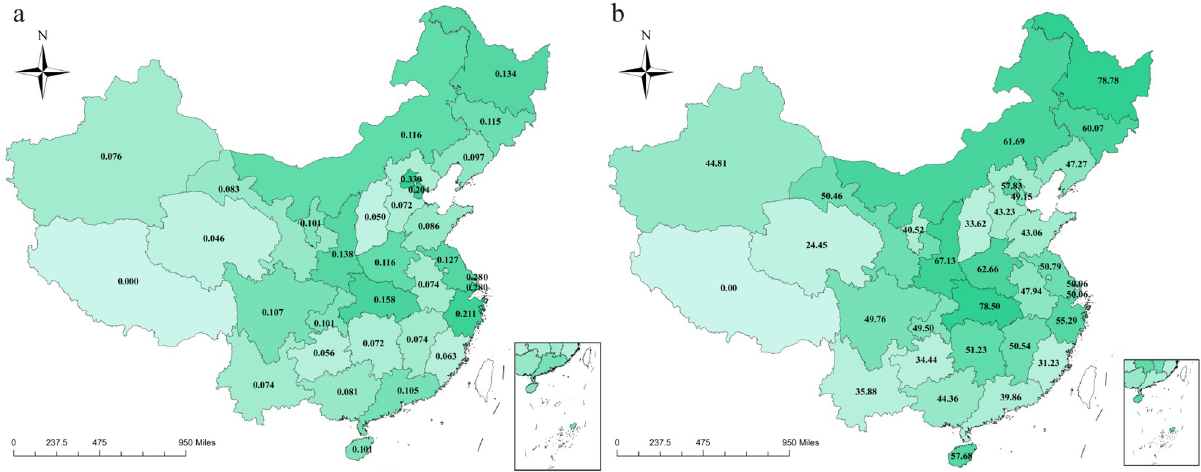
Fig 2. Instant impacts of COVID-19 on OEH visits per capita in mainland China. (a) This panel depicts the absolute instant impact of COVID-19 on monthly OEH visits per capita in February 2020 by province. Different background colors represent different regions of mainland China. The darkness of each block indicates the loss of monthly OEH visits per capita in February 2020 of each province (Tibet was excluded because of missing data). (b) This panel depicts the relative instant impact in February 2020 by province. The darkness of each block indicates the relative reduction on monthly OEH visits per capita in February 2020 of each province, compared to the pre-pandemic level. Tibet was excluded because of missing data. Maps were created using ArcGIS by ESRI version 10.8 (http://www.esri.com) [21]. Base map sources were at http://bzdt.ch.mnr.gov.cn/ and https:// dataverse.harvard.edu/dataset.xhtml?persistentId=doi:10.7910/DVN/DBJ3BX. Detailed data utilized in the creation of this figure were from the Statistical Information Center of the National Health Commission of China (http://www.nhc.gov.cn/mohwsbwstjxxzx/s2906/new_list.shtml).